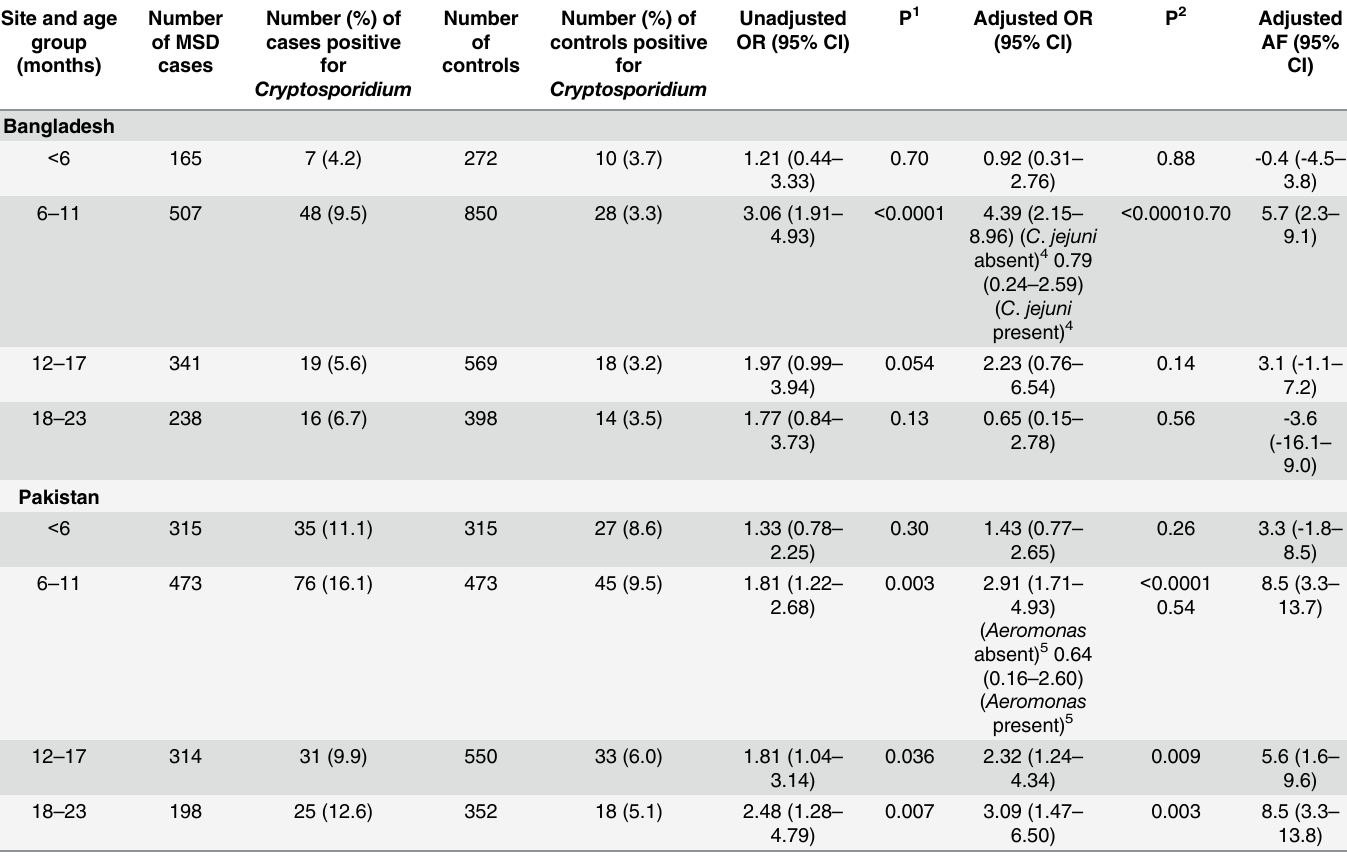
* Table 3 includes data only from study children with Cryptosporidium results. EIA: enzyme immunoassay 1 These p-values were obtained from unadjusted conditional logistic regression analysis. 2 These p-values were obtained from adjusted conditional logistic regression analysis. 3 There is an interaction (P < 0.1) between Cryptosporidium and Giardia for Mali at age 6 – 11 months. 4 There is an interaction (P < 0.1) between Cryptosporidium and C . jejuni for Bangladesh at age 6 – 11 months. 5 There is an interaction (P < 0.1) between Cryptosporidium and Aeromonas for Pakistan at age 6 – 11 months. 4.88 (95% CI, 0.82 – 8.92) in infants and 4.04 (95% CI, 0.56 – 7.51) and 4.71 (95% CI, 0.24 – 9.18) in toddlers, per 100 child-years. Applying these incidence rates to the pediatric population age < 2 years in the SSA and I/P/ B/N/A regions, respectively, yielded annual estimated Cryptosporidium MSD burdens of ~1.2 million and ~1.5 million cases. The total number of LSD and MSD cases was estimated to be 2.9 million in this age group in SSA and 4.7 million in the populous I/P/B/N/A region (Table 4). The proportions of cases due to C . hominis and C . parvum in the subset tested for species were multiplied by the total estimated number of Cryptosporidium -attributable diar- rhea cases in both regions (~7.6 million), yielding estimates of 5.9 million C . hominis , 0.76 mil- lion C . parvum and 90,000 thousand co-infected ( C . hominis plus C . parvum ) cases in children aged < 2 years.